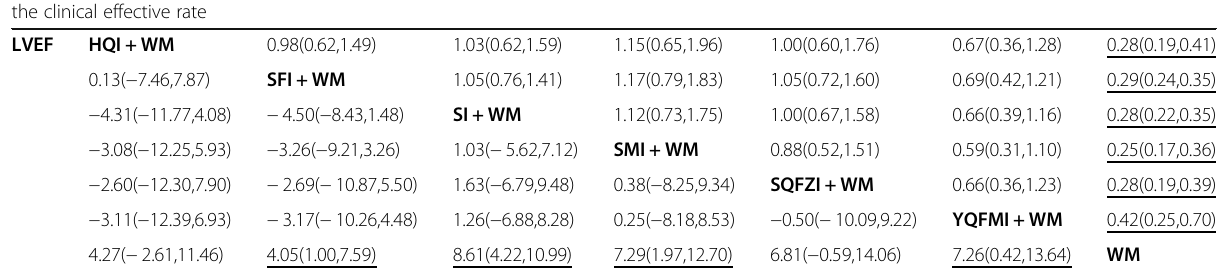
Table 1 Odds ratios/mean difference (95%CIs) of the clinical effective rate (right upper part) and LVEF (left lower part) the clinical effective rate